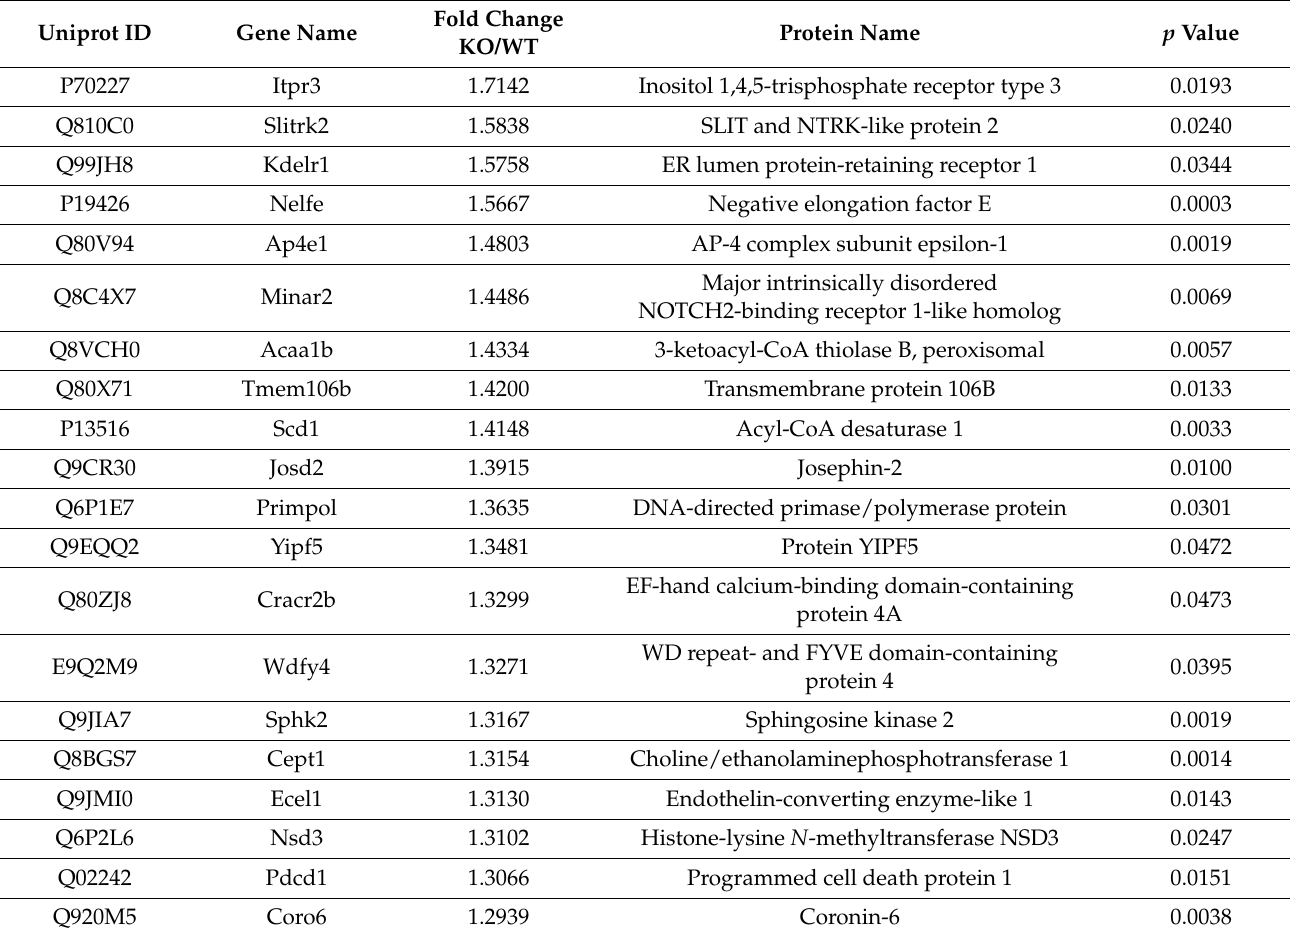
Table 1. Up-regulated hepatic DEPs in Selenot -KO mice (top 20).